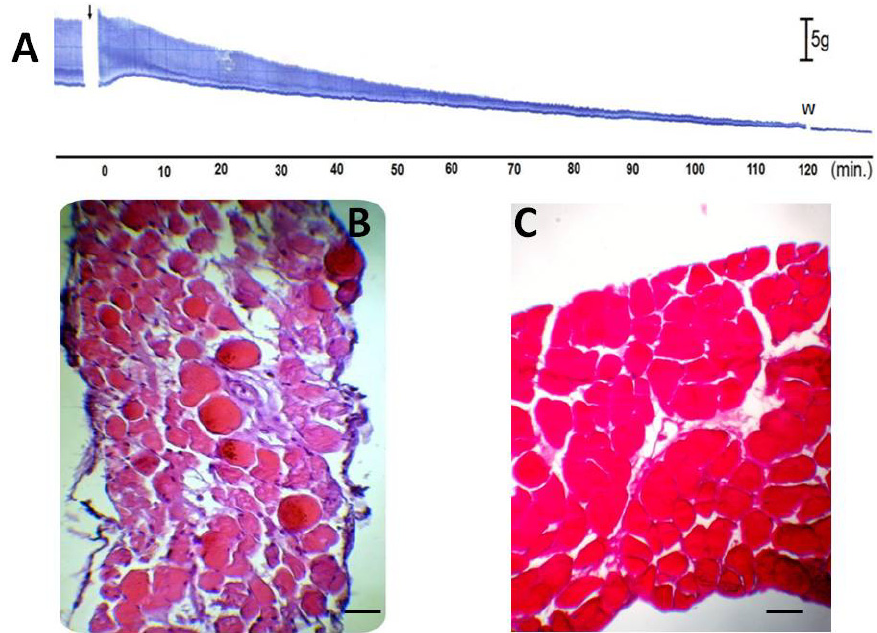
Figure 5. Neuromuscular responses of indirectly stimulated PND incubated with B. jararacussu venom (40 μ g/mL) for 120 min ( A ). Notice the irreversible blockade. Venom was added at the arrow. Bar = tension of 5 g/cm. W = wash. Panel ( B )—Cross-section of diaphragm muscle incubated with venom alone (40 μ g/mL, n = 6). Note the edema and intense myonecrosis (muscle fiber atrophy, hyaline aspect, sarcolemmal disruption and myofibril lysis). Panel ( C )—Cross-section of diaphragm muscle incubated with a mixture of TM (200 μ g/mL) + venom (40 μ g/mL). Note the normal appearance of the fibers (polygonal aspect and peripheral nuclei), but with occasional edema. Bar = 50 μ m